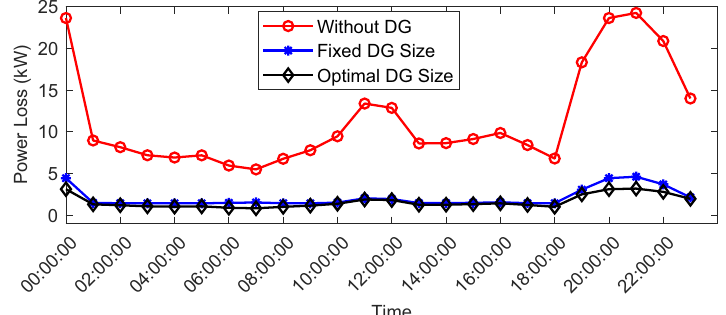
Fig. 5 The estimated hourly power losses for Tanzania power system